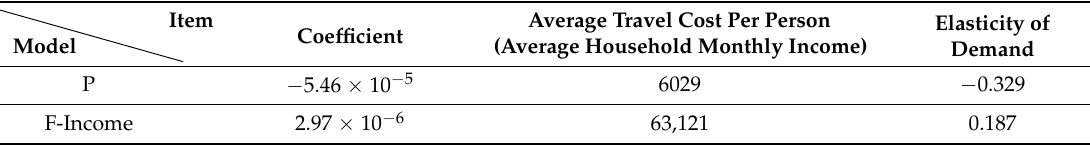
Table 7. Price elasticity and income elasticity of the variables in the on-site Poisson